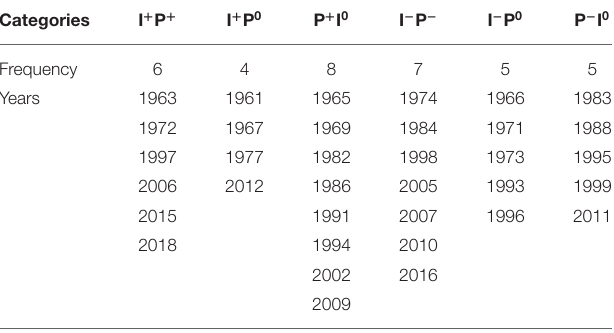
TABLE 3 | Years of IOD and ENSO combinations.